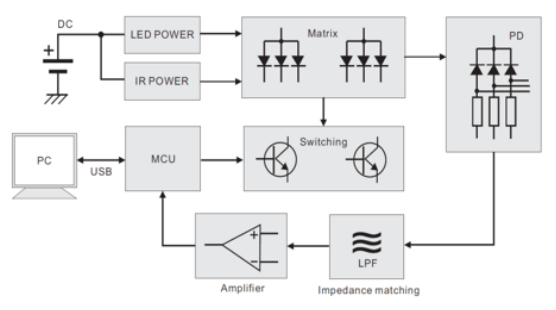
Figure 5. A block diagram of MSP acquisition